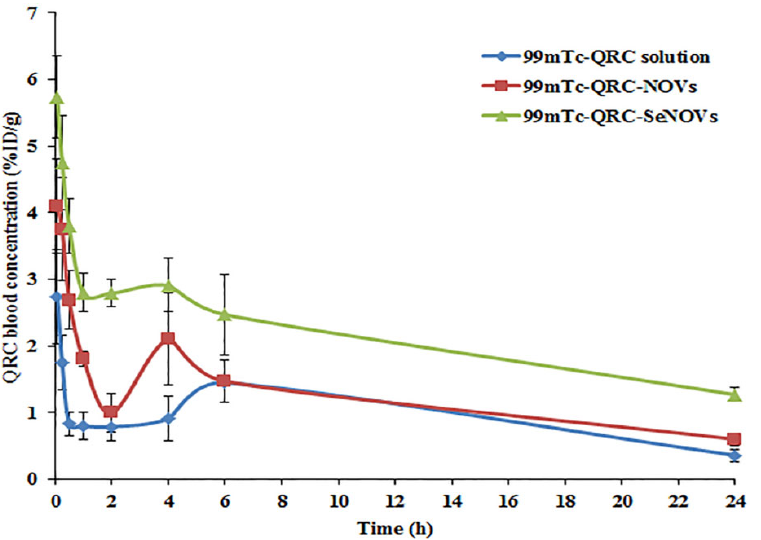
Figure 7. QRC blood concentration at various time intervals following i.v. administrations of 99m Tc- QRC solution, 99m Tc-QRC-NOVs, and 99m Tc-QRC-SeNOVs in Ehrlich tumor-bearing adult male Swiss albino mice, mean ± SD, n =